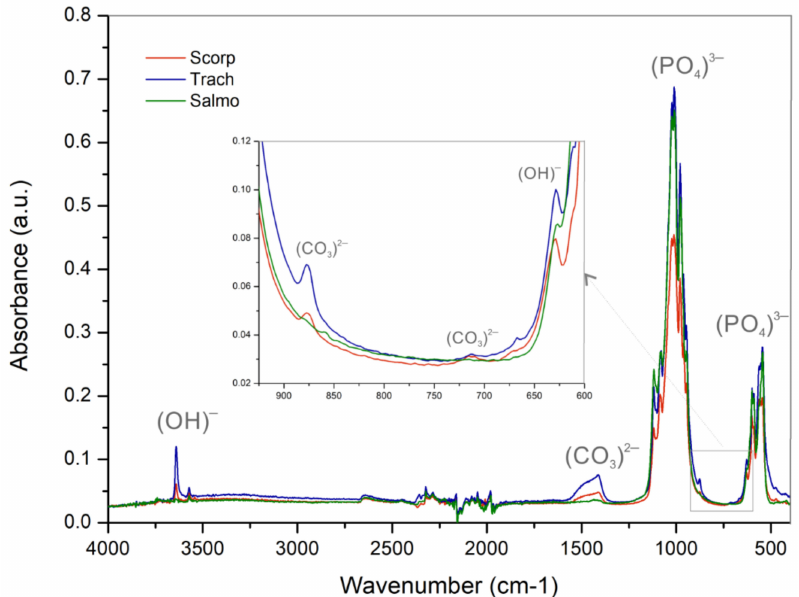
Figure 5. Fourier transform infrared spectra of fish bone samples thermally treated at 950 ◦ C.